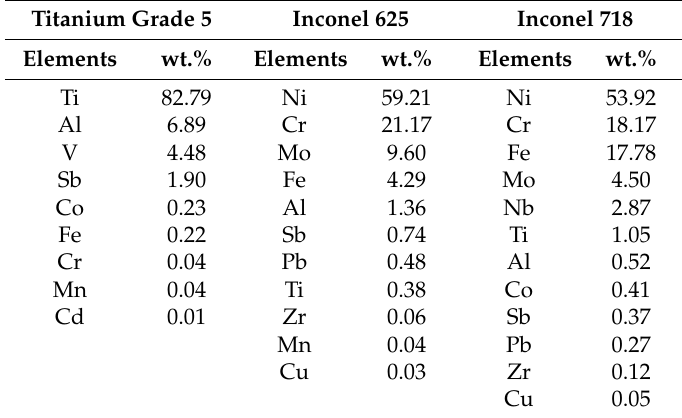
Table 3. The Inductively Coupled Plasma Optical Emission Spectrometry (ICP-OES) elemental results of alloy swarfs analyses.